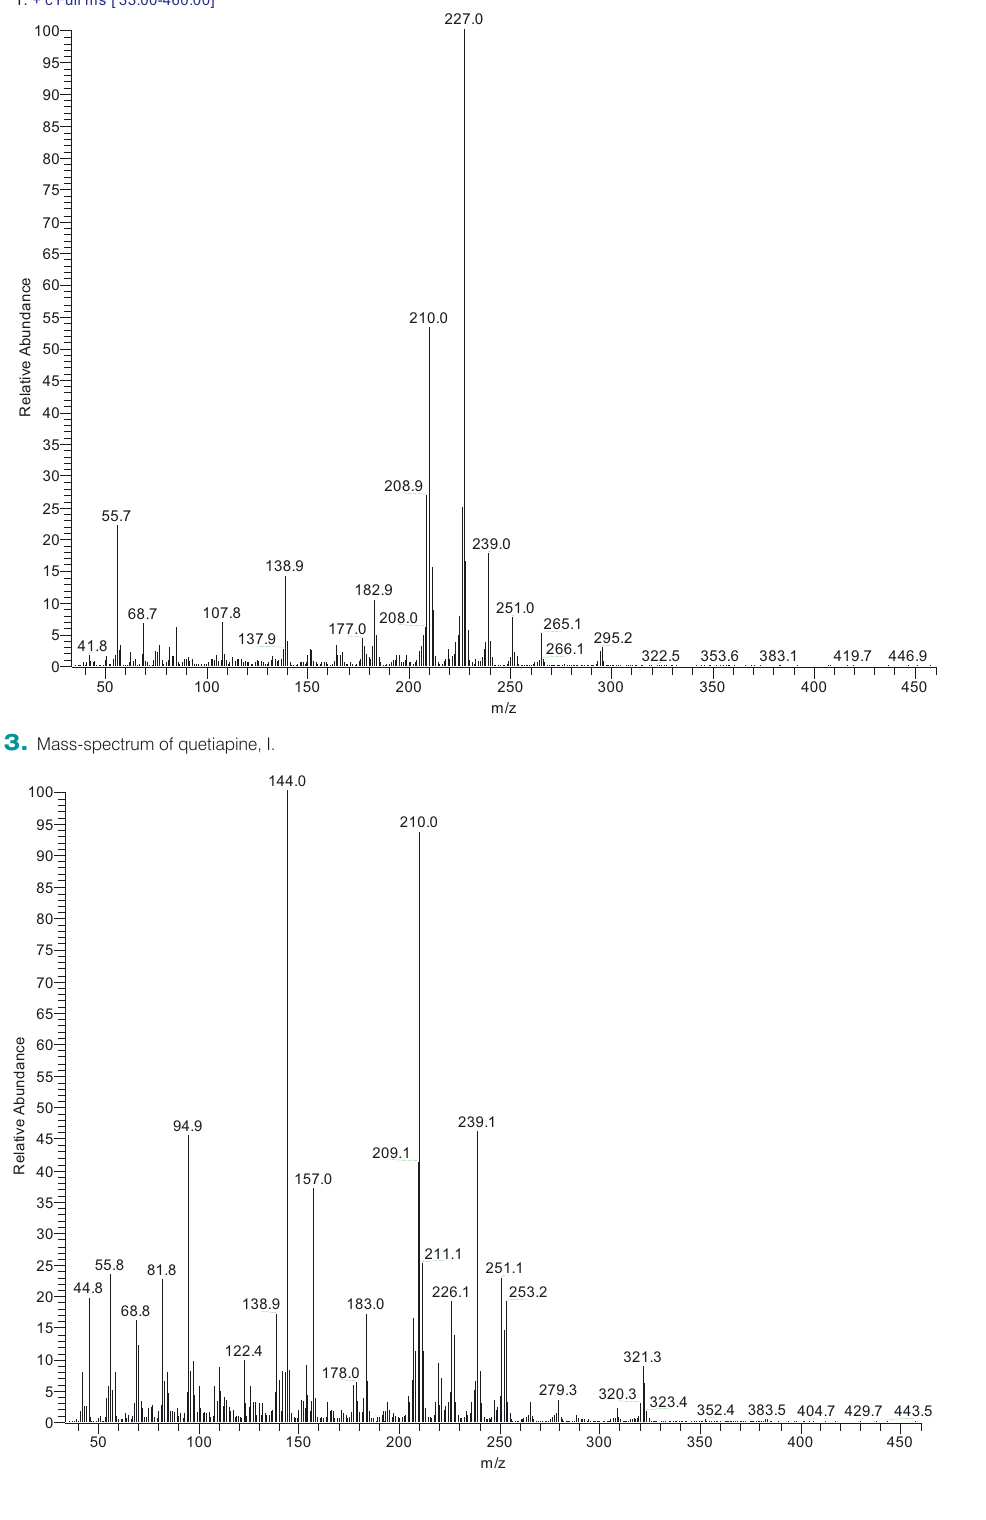
Figure 2. Mass-spectrum of N-desalkylquetiapine, II.